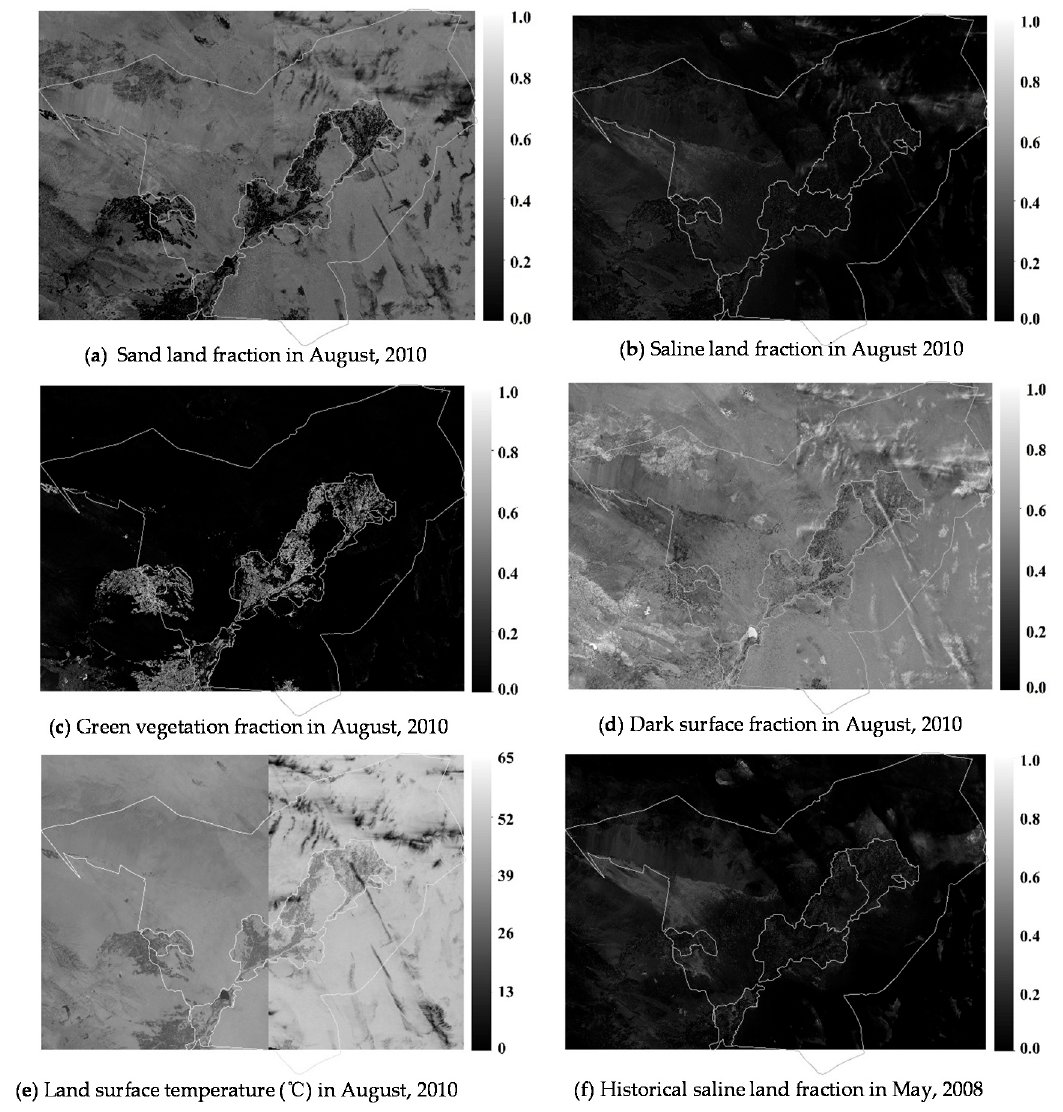
Figure 3. Spatial distribution of independent variables. ( a ) SL fraction in 2010; ( b ) SA fraction in 2010; ( c ) GV fraction in 2010; ( d ) DA fraction in 2010; ( e ) LST in 2010; ( f ) SAH in 2008